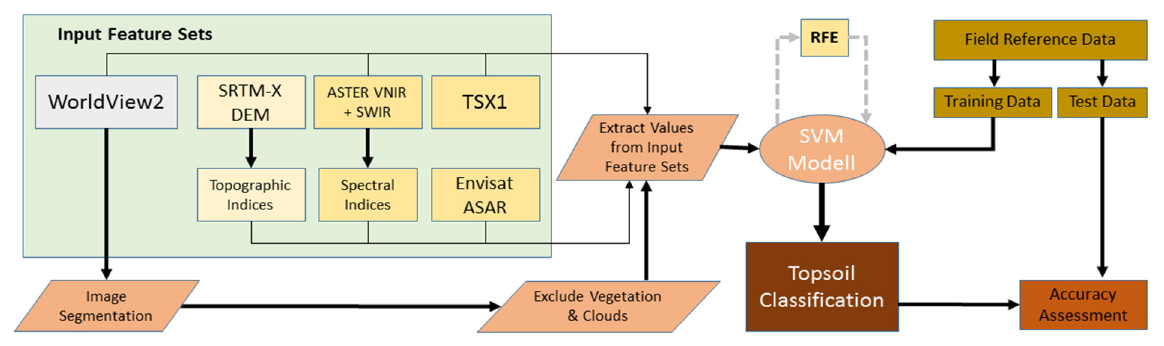
Figure 4. Proposed workflow. RFE, recursive feature